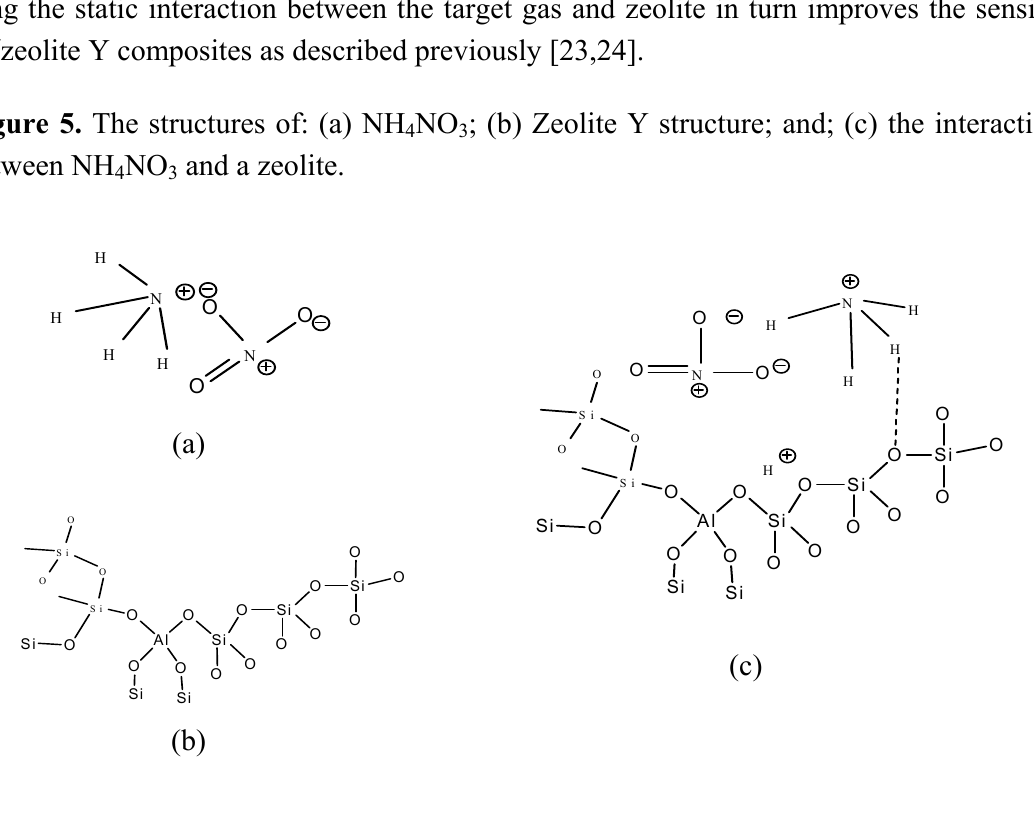
NO ; (b) Zeolite Y structure; and; (c) the interaction 4 3